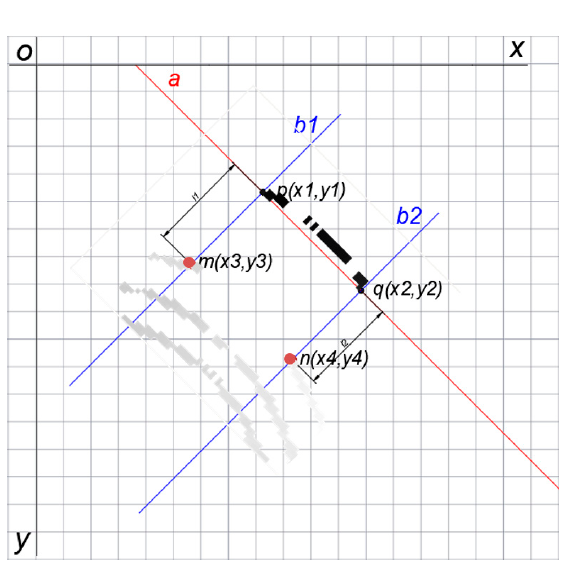
Figure 11. The mathematical model for width estimation.